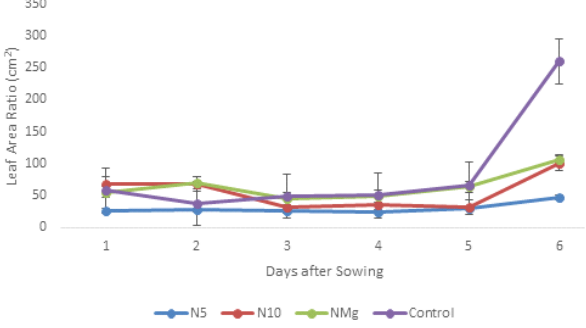
Fig. 4. The effect of different levels of Magnesium application on the leaf area ratio of C.